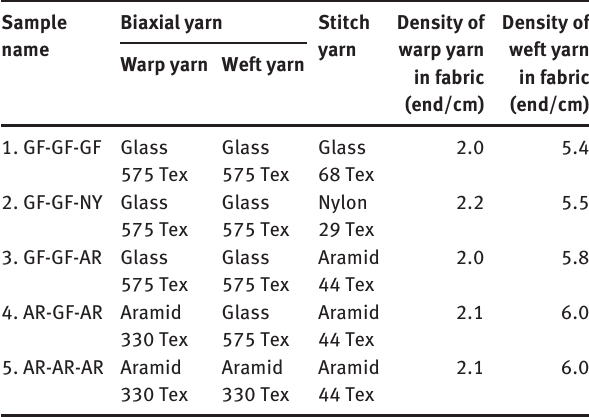
Table 1 Parameters of the BWK